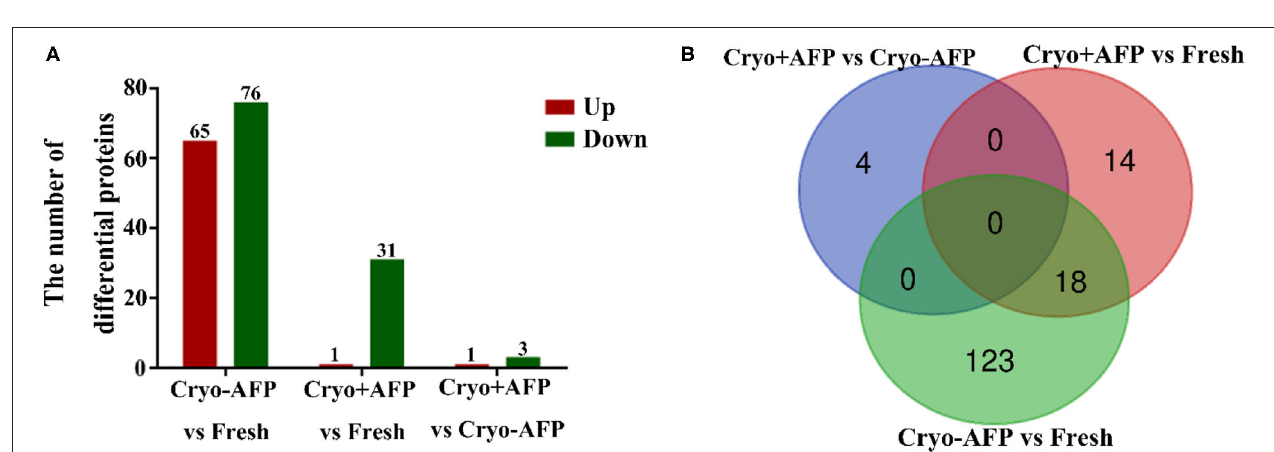
FIGURE 2 | Identification of differentially expressed proteins in cynomolgus macaque sperm. (A) The number of differentially identified cynomolgus macaque sperm proteins between Fresh and Cryo–AFP, between Fresh and Cryo + AFP, and between Cryo–AFP and Cryo + AFP groups. The upregulated and downregulated proteins were represented by the red and green bars, respectively. (B) The differences in identified differentially expressed proteins as shown by the Venn diagram between Fresh, Cryo–AFP, and Cryo + AFP groups.